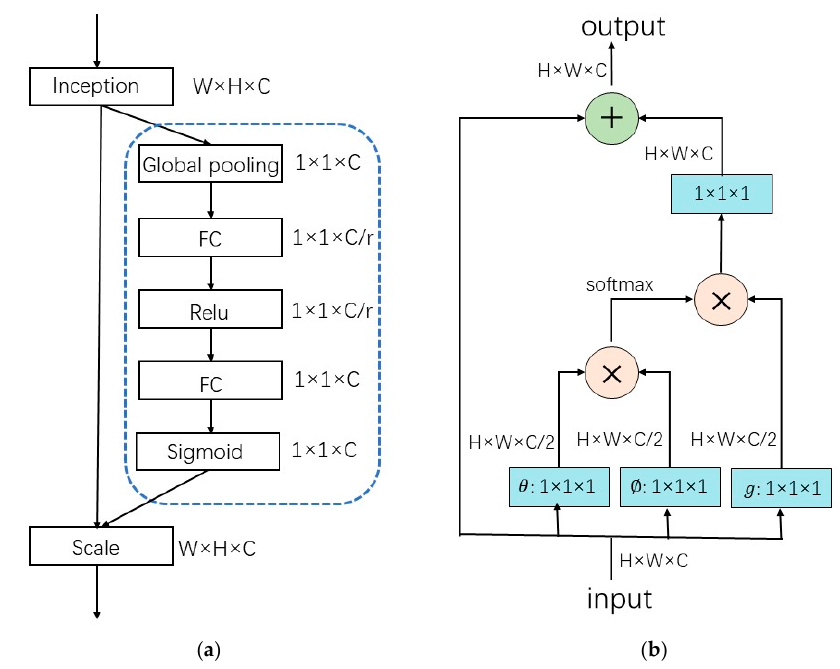
Figure 4. ( a ) SE-Net module structure; ( b ) Non-Local module